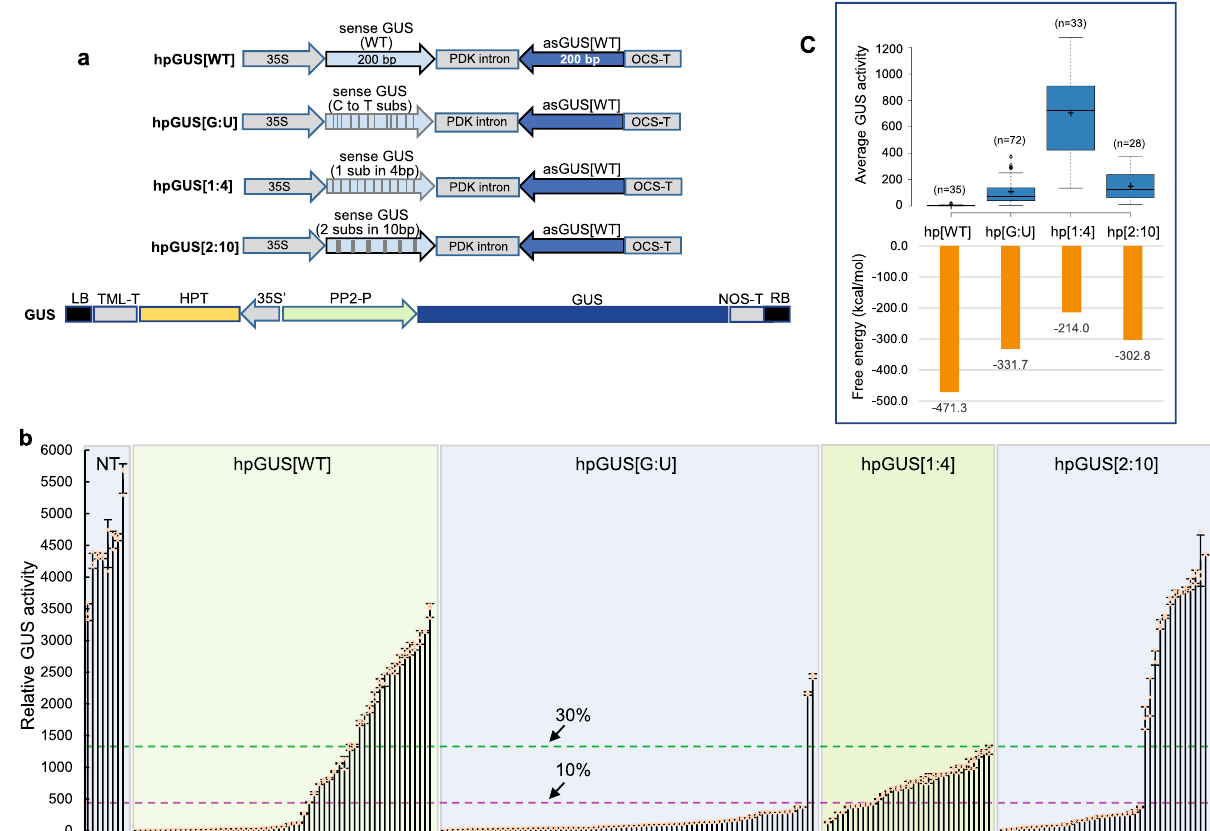
Fig. 1 G:U and 1:4 mismatched GUS hpRNA constructs induce uniform GUS RNAi in tobacco. a Schematic diagram of the four GUS hpRNA constructs and the target GUS gene in PPGH11 and PPGH24 plants. 35S, the longer version (~1.3 kb) of the cauli fl ower mosaic virus 35S promoter; 35S ’ , a shorter version (337bp from nt. − 285 to + 50) of the 35S promoter from pTRA151 vector; OCS-T, NOS-T, and TML-T, the transcriptional terminator sequences of the Agrobacterium tumefaciens octopine synthase, nopaline synthase, and tumor morphology large genes, respectively. HPT, hygromycin phosphotransferase gene; PP2-P, the Cucurbit pepo PP2 protein gene promoter. b GUS activity in independent T0 plants transformed with the conventional and modi fi ed hpRNA constructs. Each bar represents an independent T0 transgenic plant. Three technical replicates were measured for each line, and data are presented as mean values±s.d. with the three data points shown as orange cross. The dashed green and pink lines indicate the 30 and 10% GUS activity levels of the untransformed PPGH11 and PPGH24 plants (NT). c The average levels of GUS silencing in the strongly silenced lines of hpGUS[WT], hpGUS[G:U] and hpGUS[2:10] and all the silenced plants of hpGUS[1:4] show a good correlation with the thermodynamic stability of predicted hpRNA structures. The boxplots (BoxPlotR, http://shiny.chemgrid.org/boxplotr/) above show the distribution of GUS activities of 35 hpGUS[WT], 72 hpGUS[G:U], 33 hpGUS[1:4], and 28 hpGUS[2:10] lines. The central horizontal line indicates the median value; the lower and upper borders of the box represent the fi rst and third quartiles; whiskers extend 1.5 times the interquartile range from the fi rst and third quartiles; outliers are represented by dots; crosses represent sample means. Source data are provided as a Source Data fi le.